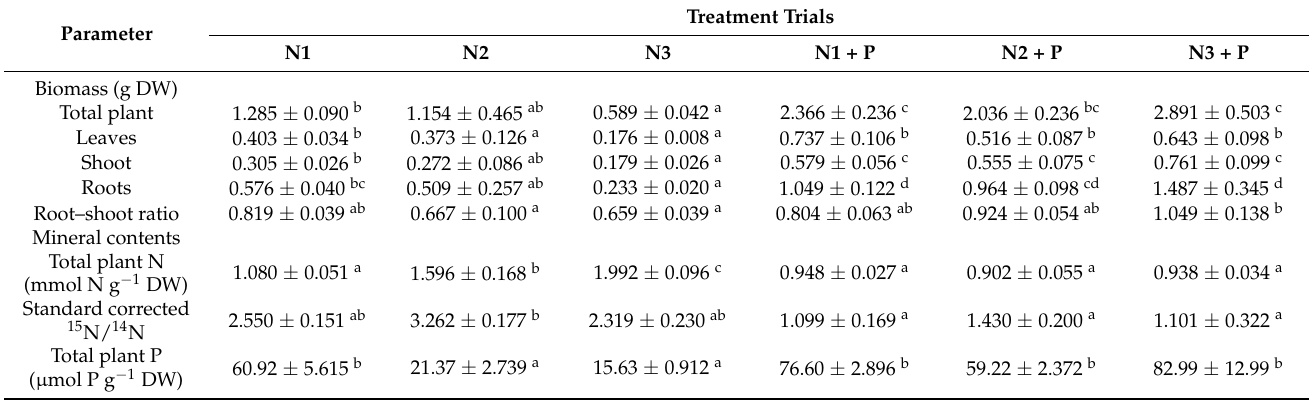
Table 1. Biomass and mineral contents of 180-day-old L. leucocephala plants grown in Veld Fertilizer Trial soils from Ukulinga Experimental Farm, South Africa. Values represent the mean ± SE, based on n = 5. Significant differences among treatments are denoted by different superscript letters ( p <